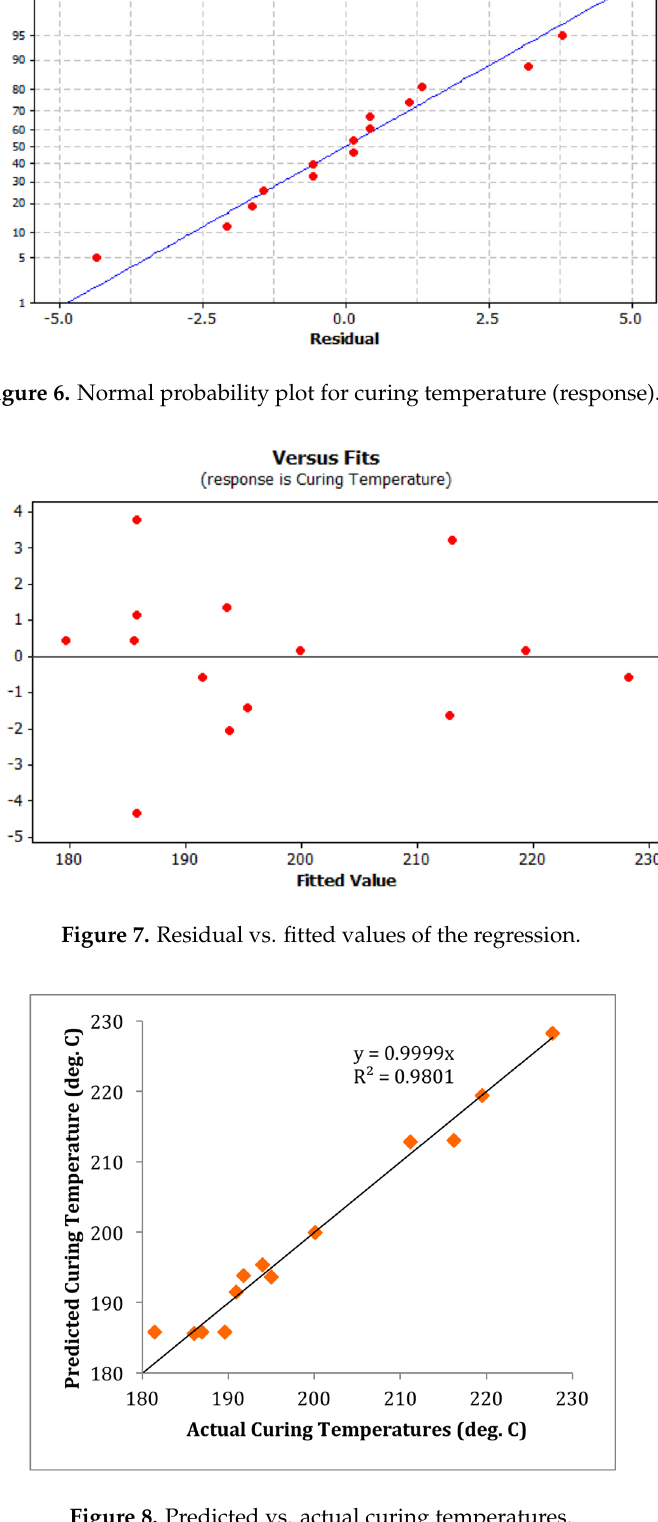
Figure 8. Predicted vs actual curing temperatures.